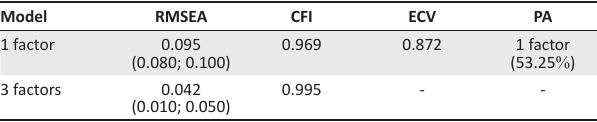
TABLE 1: Stage-1 results: Basic internal assessment (Part a). Model